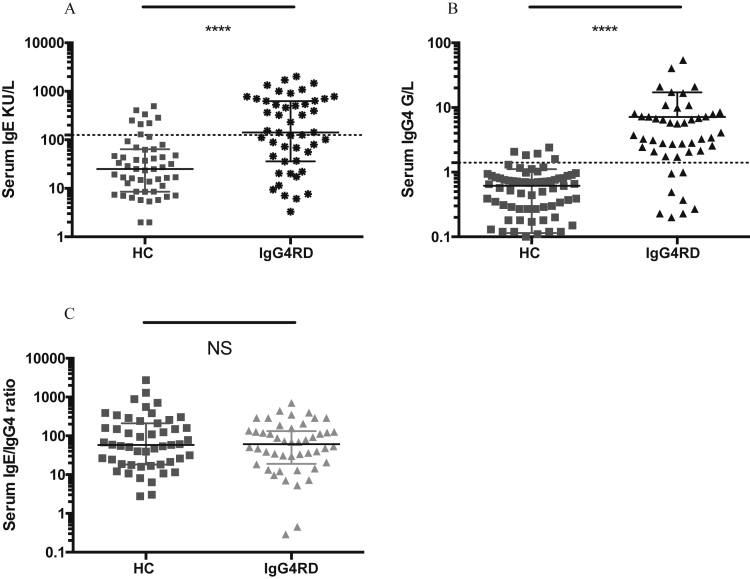
Serum IgG4 and IgE levels and IgE/IgG4 ratio in IgG4-RD and HC. Dot plots showing (A) serum IgG4 concentrations, (B) serum IgE concentrations, (C) IgE/IgG4 ratio (kIU/g), in IgG4-RD patients and HC. The y-axis shows the serum IgE concentration (KU/L), serum IgG4 (g/L), or IgE/IgG4 ratio. Dashed line is the serum IgE upper limit of normal (≥125 kIU/L) and serum IgG4 upper limit of normal (≥1.4 g/L). Mann-Whitney P values; NS P < .05, ****P < .0001.